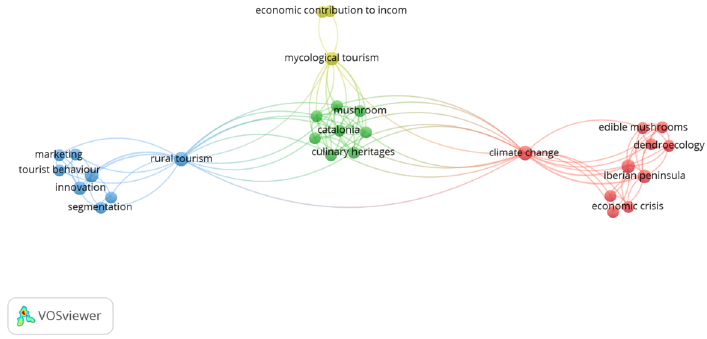
Figure 2. Keywords. Own elaboration.